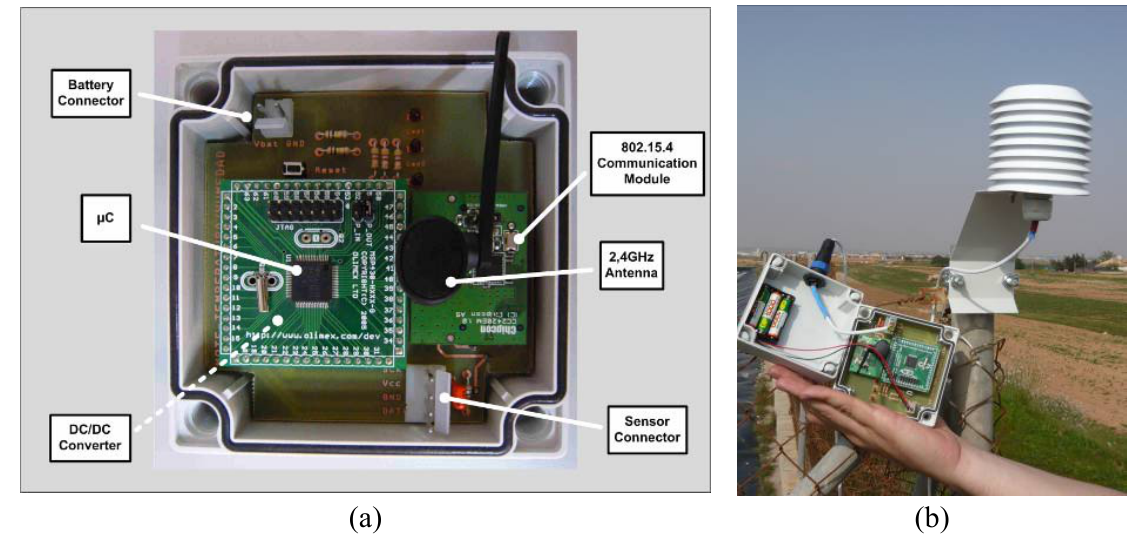
Figure 4. Views of the different prototypes developed with similar architecture to the GAIA Soil-Mote. (a) Environmental-Mote. (b) Environmental-Mote installed in the field. (c) Data-Sink/Gateway. (d) Data-Sink/Gateway installed in the field. (e) Water-Mote. (f) Water-Mote installed in the